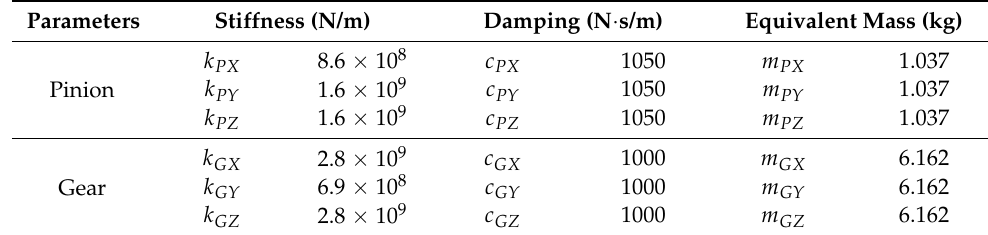
Table 3. Parameters of the pinion and